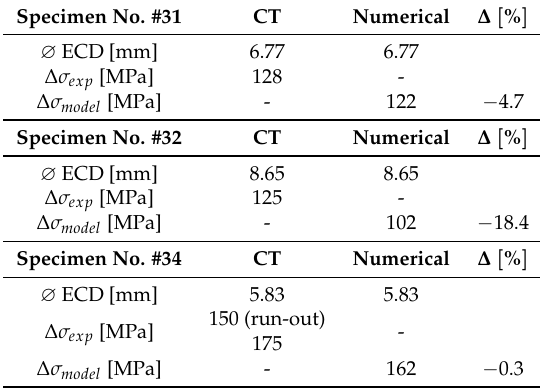
Table 6. Comparison of computed tomography and numerically generated porosities. Equivalent circle diameter